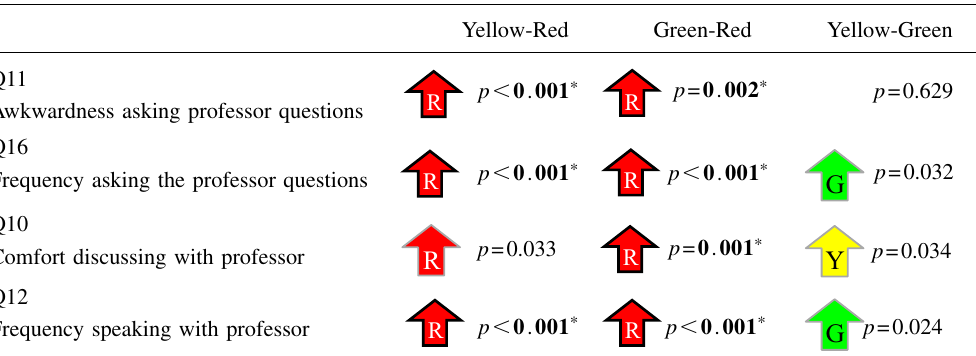
TABLE III. (cid:1) Color (cid:2) Mann-Whitney U Test Results for Pair-wise Comparisons on Faculty-Student Col- laboration Survey Questions. The arrows in the table indicate which group tends to yield higher (cid:1) more favorable (cid:2) responses for all p -values less than 0.1. Bold font (cid:1) with astrik (cid:2) indicate statistically significant results.